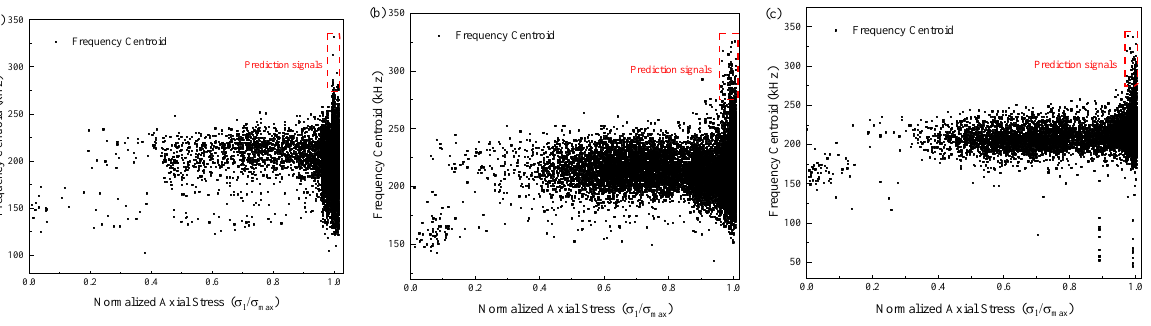
Figure 8. Relationship between frequency centroid distribution and normalized axial stress. ( a ) A1, ( b ) B1, ( c ) C1.